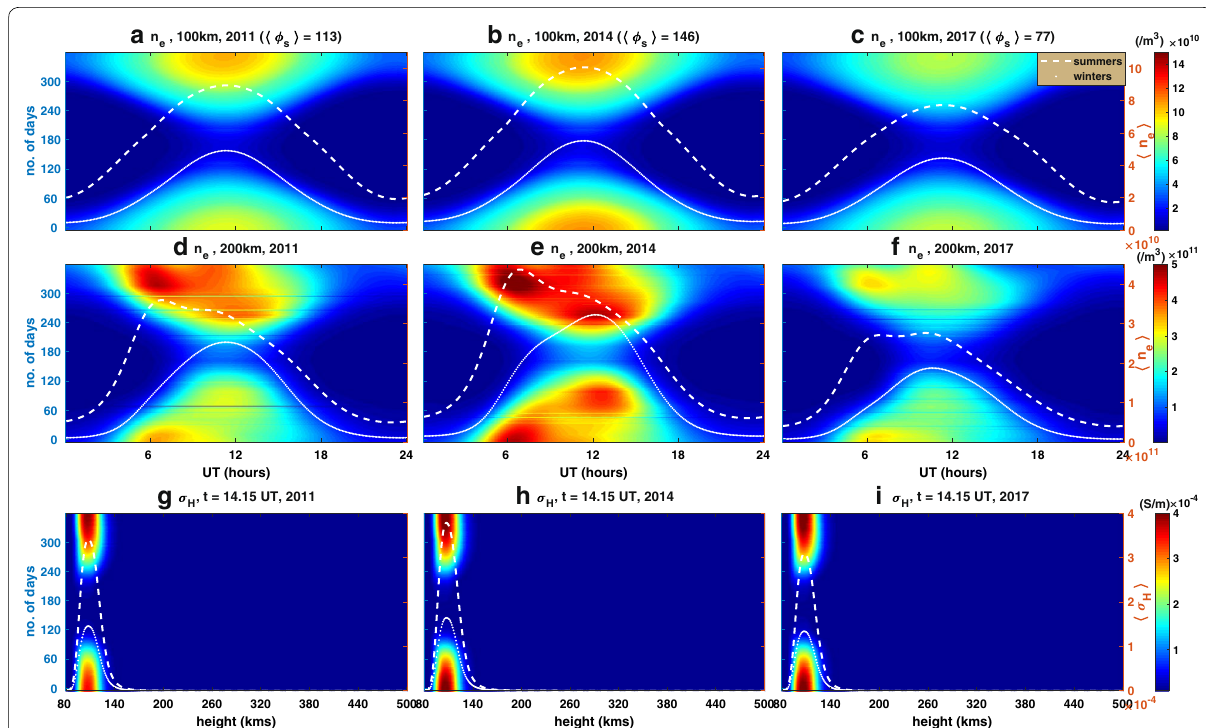
Fig. 10 For Maitri, a – c the annual variation of electron density ( / m 3 ) at 100 km altitude as a function of time for 2011, 2014, 2017, respectively. d – f The annual variation of electron density ( / m 3 ) at 200 km altitude as a function of time for 2011, 2014, 2017, respectively. g – i show annual variation of Hall conductivity ( S / m ) as a function of altitude at 14.15 UT hours for 2011, 2014, 2017, respectively. Average solar fluxes for 2011, 2014, and 2017 are 113, 146 and 77 s.f.u., respectively. With white solid and dashed lines, we have shown the average values of the corresponding parameters for winter and summer, respectively. These parameters are obtained using the IRI model and the WDC Kyoto ionospheric conductivity